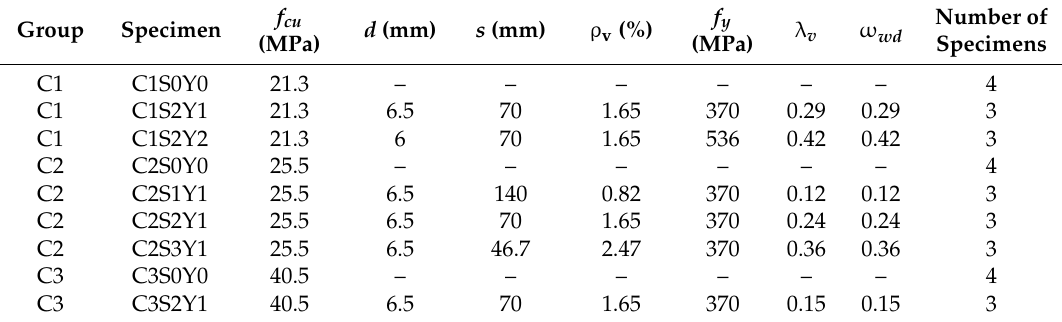
Table 4. Mechanical and geometrical properties of all